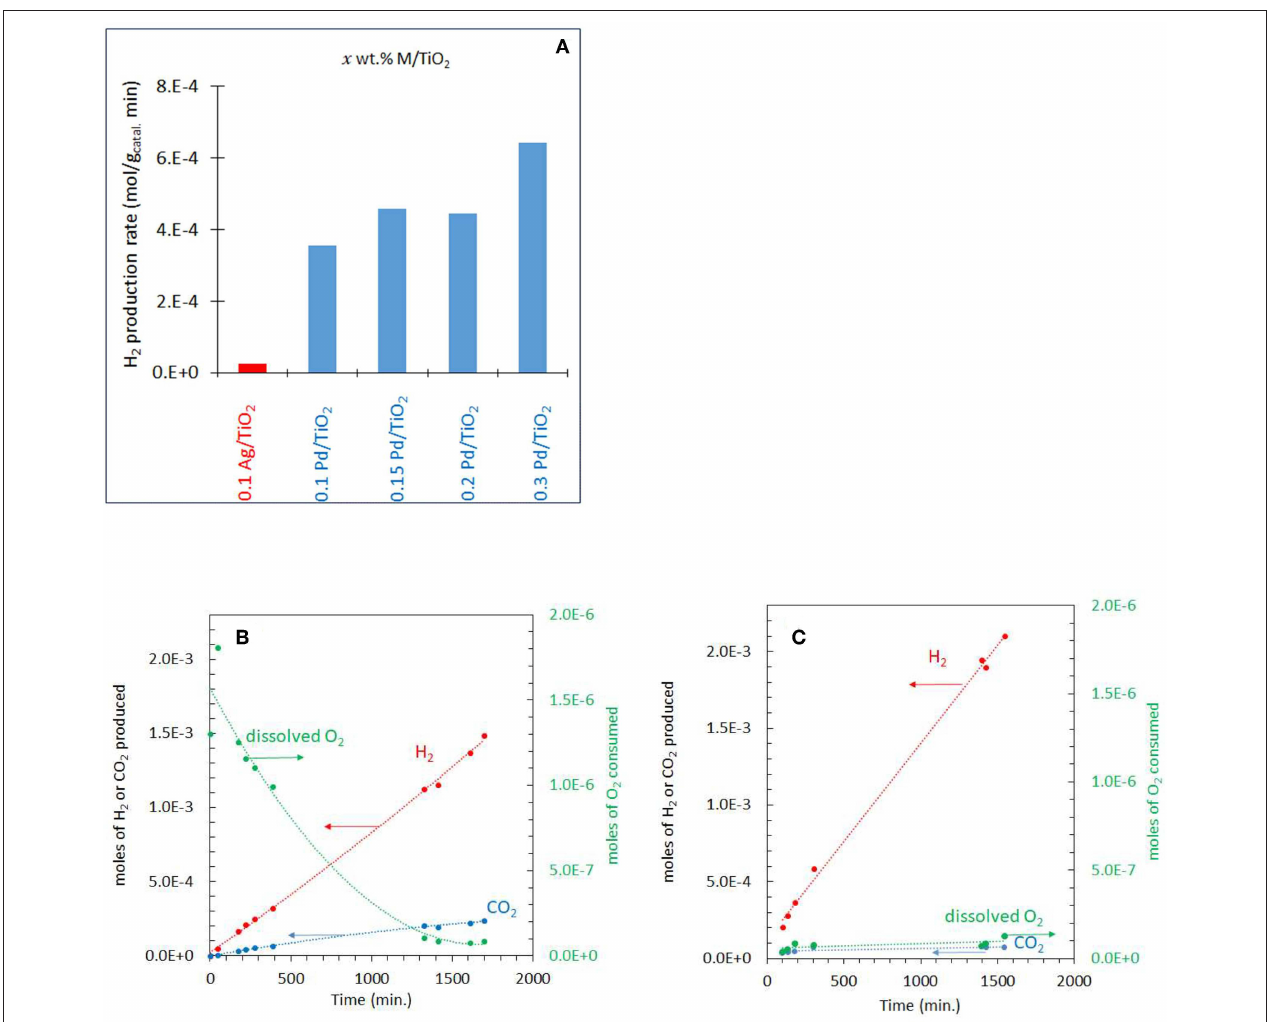
FIGURE 4 | (A) Comparison of the performance of the monometallic catalysts for hydrogen production from ethylene glycol at 0.001 atm of O 2 . (B) Photoreaction at 0.05 atm P O2 with 5 vol.% (0.67M) ethylene glycol and 2mg of 0.1 wt.% Ag − 0.3 wt.% Pd/TiO 2 (anatase) catalyst. (C) Photoreaction at 0.001 atm P O2 with 5 vol.% (0.67M) ethylene glycol and 2mg of 0.1 wt.% Ag − 0.3 wt.% Pd/TiO 2 (anatase)